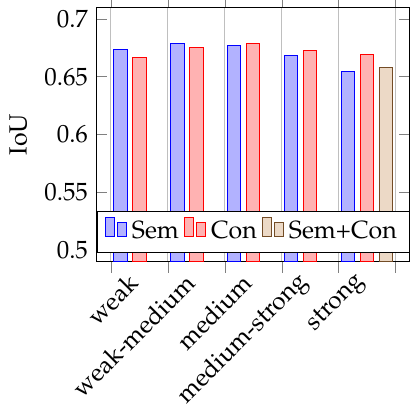
Figure 6. Mean IoU on synthetic data.